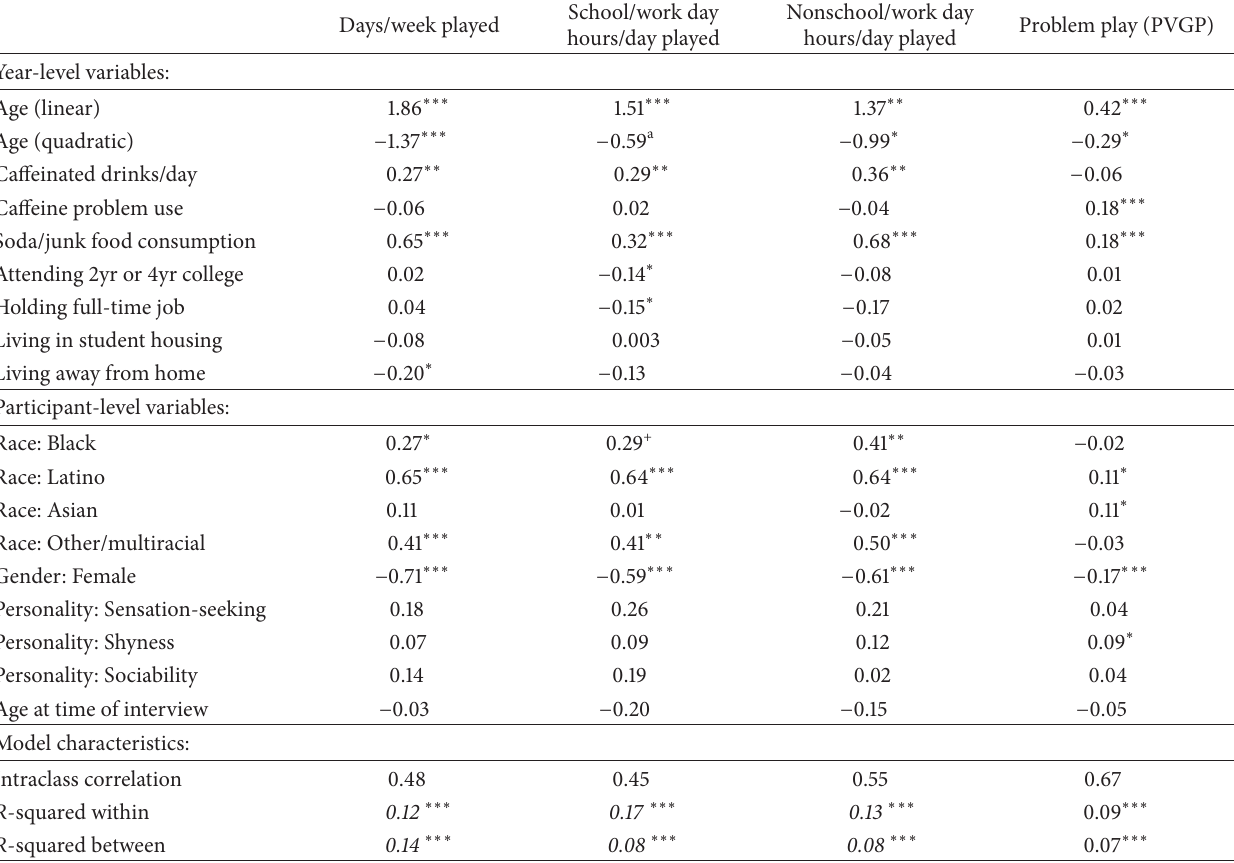
Table 1: Results of multilevel model predicting video gaming habits from study